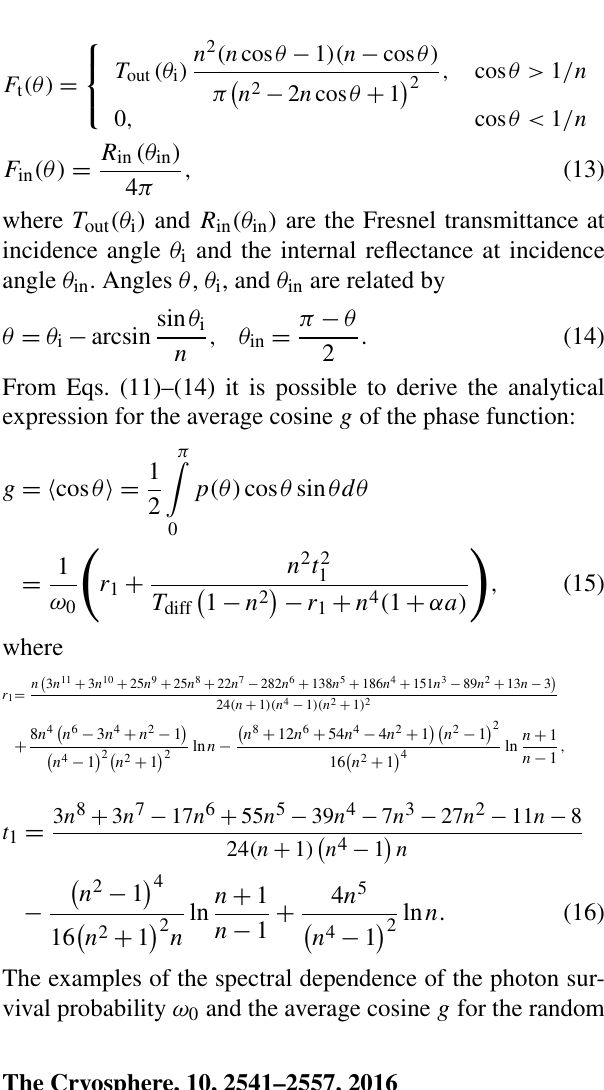
Figure 3. Spectral dependence of the photon survival probability (solid) and the average cosine (dashed) for the random ice–air mix- ture with a mean chord of 30µm (blue) and 3mm (red).